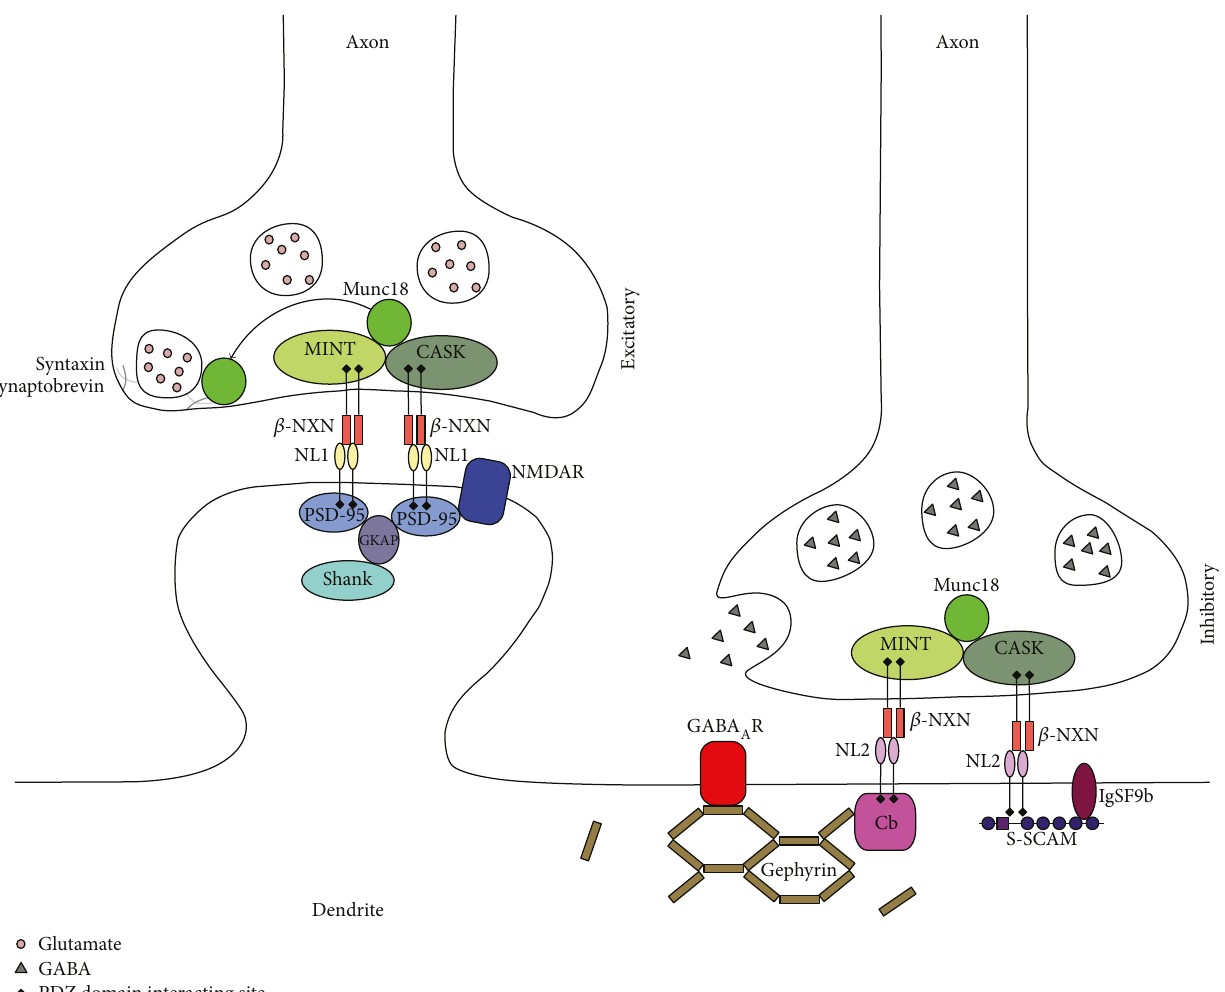
Figure 1: Diagram depicting the localization and interactions of NL1, NL2, and Cb at excitatory and inhibitory synapses. The extracellular domains of NL1 and NL2 bind presynaptic neurexins, which are bound to the presynaptic sca ff old proteins Munc18 interacting protein (MINT) and calcium/calmodulin-dependent serine protein kinase (CASK). NL1 is located at excitatory synapses and binds the postsynaptic density protein 95 (PSD-95) intracellularly, which also binds NMDA receptors. NL1 also directly or indirectly binds the Shank family sca ff olding proteins. NL2 is located at inhibitory synapses and binds to synaptic sca ff olding molecule (S-SCAM) as well as collybistin, which recruits the sca ff olding protein gephyrin from intracellular stores (not shown) to the postsynapse. Gephyrin mediates the accumulation of GABA receptors to the membrane (for reviews, see [32, A